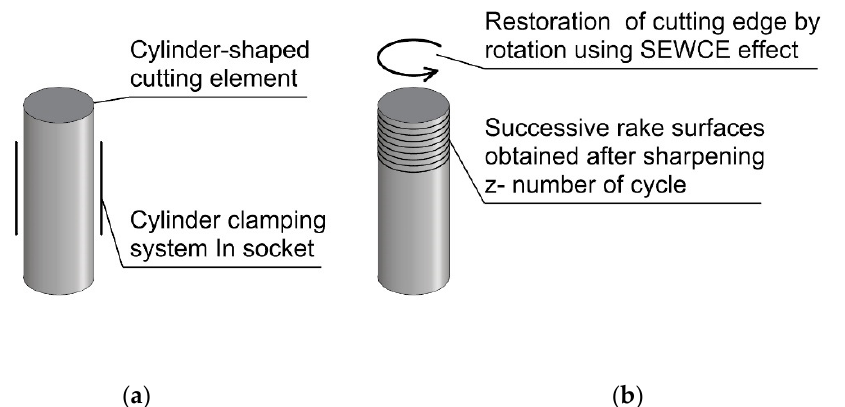
Figure 9. The essence of restoring cutting-edge properties with a cylindrical cutting element: ( a ) design concept for the tool; ( b ) phases of using the rotation of the cutting element and sharpening the rake surface.